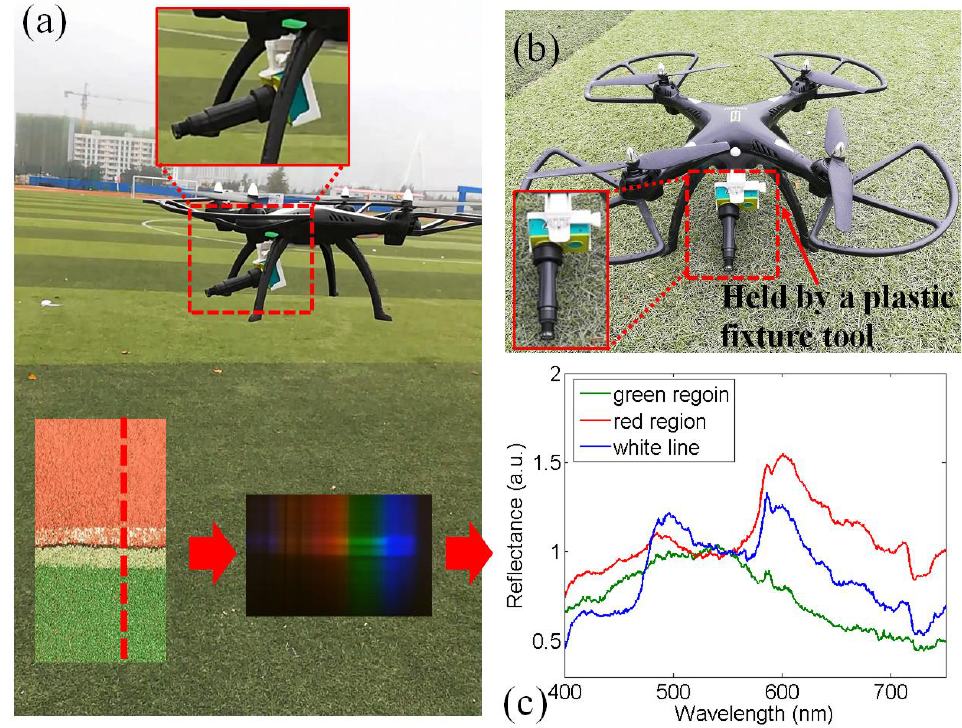
Figure 5. The compact imaging spectrometer can be installed in a consumer UAV for spectral detection. ( a , b ) show two views of the aerial spectral detection system, respectively. We flew the system over an athletic field to measure reflectance from the field and the track. The reflectance of the green artificial grass, the red plastic track, and a white line in the track are shown. ( c ) Spectra of three detected objects.